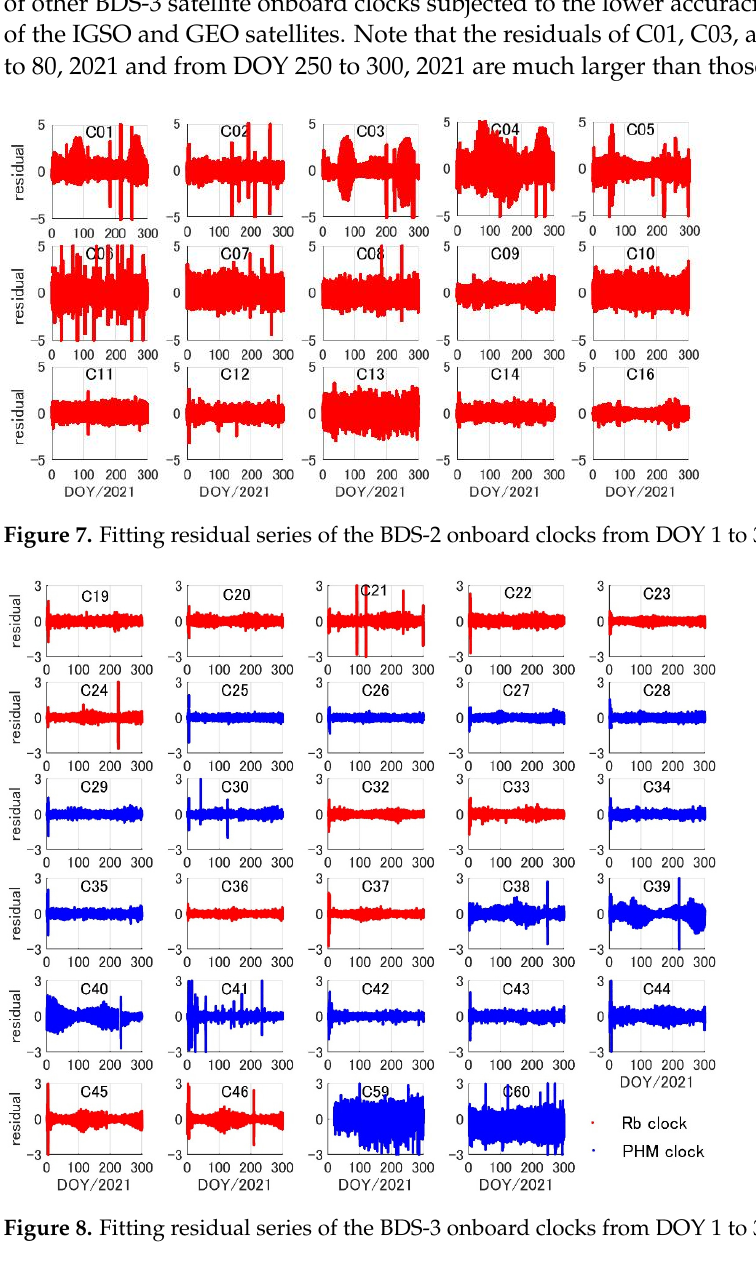
Figure 9. RMS of clock fitting residuals of BDS-2 and BDS-3 GEO, IGSO, and MEO satellites.